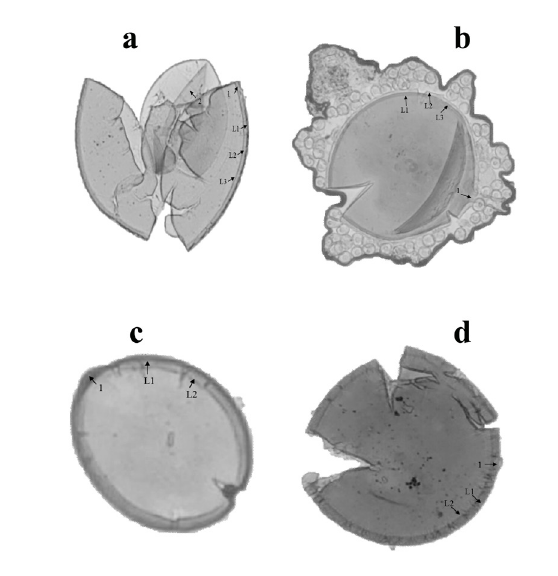
Figure 2 - Species of arbuscular mycorrhizal fungi (AMFs) identified in the study areas, (a) Acaulospora mellea – spore without ornamentation, presence of scar (1a), reaction with melzer (2a) and wall composition with three layers (L1, L2 and L3); (b) Glomus sp1 – glomus type spore (1b), without ornamentation, hyaline and with three layers on the wall (L1, L2 and L3); (c) Glomus sp 2 – small scale spore of 100μm, glomoide type (1c), without ornamentation, with thick layer of two layers (L1 and L2); (d) Glomus sp3 – large spore in 100μm scale, glomid type (1d), without ornamentation, with thick wall and two layers (L1 and L2).